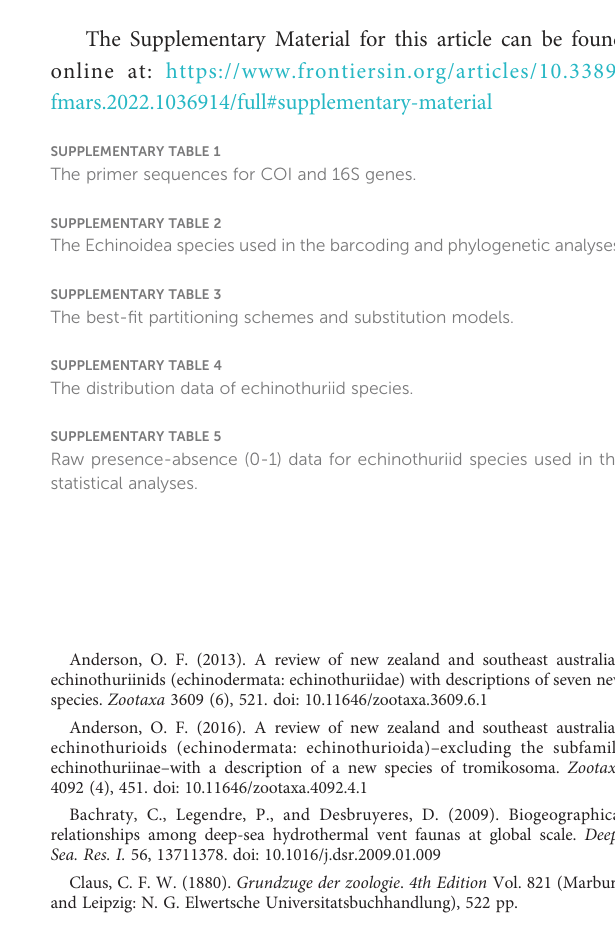
SUPPLEMENTARY TABLE 1 The primer sequences for COI and 16S genes.